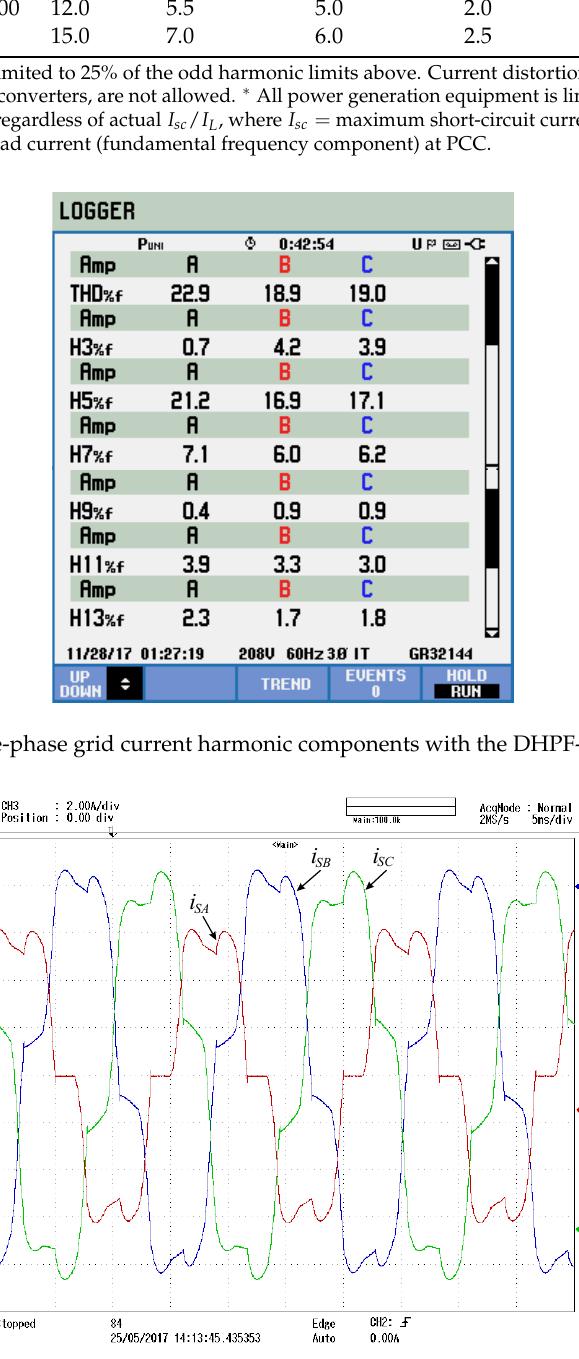
Figure 10. Three-phase grid current waveforms with the DHPF-NSI